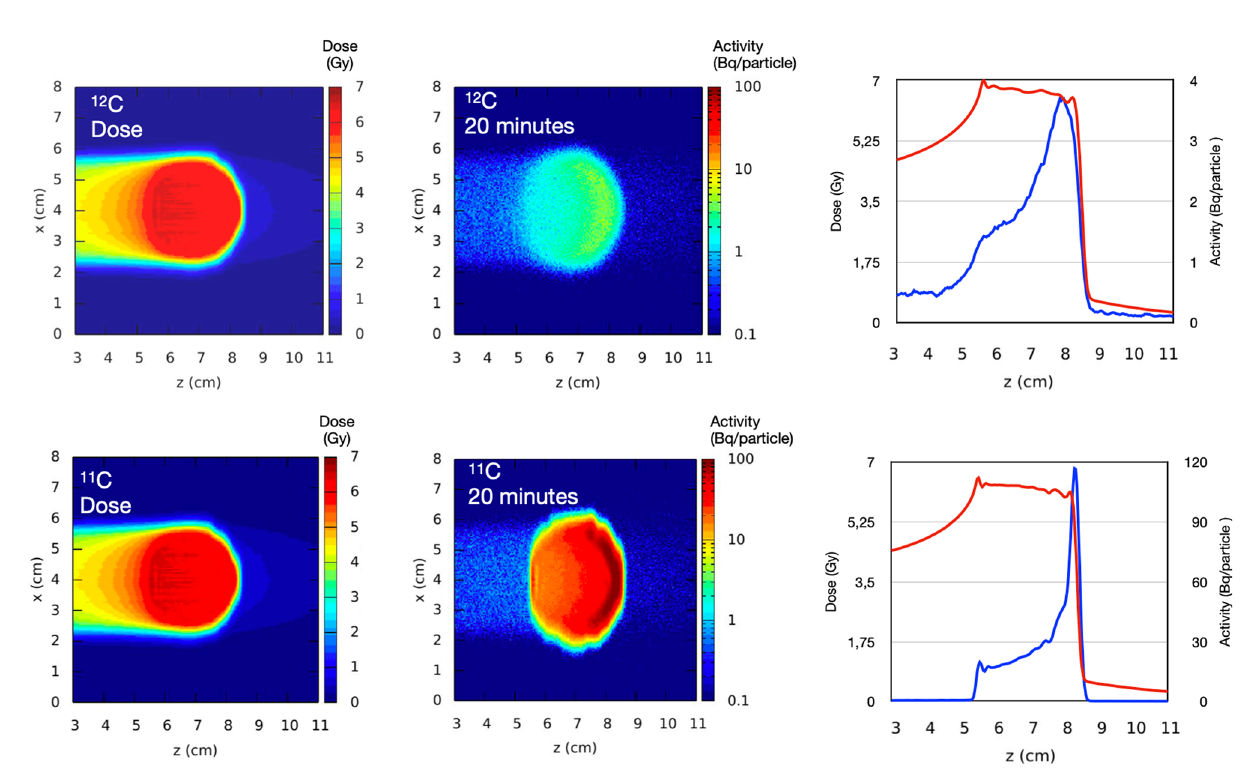
FIGURE 1 | Monte Carlo simulation of 12 C and 11 C beams stopping in a spherical water volume and visualized by PET in 20 min. The graphs show the dose (red curve) and the activity (blue curve) distribution along the beam direction (z-axis) showing the shift between dose and activity when stable ions are used. Simulation by Monte Carlo code